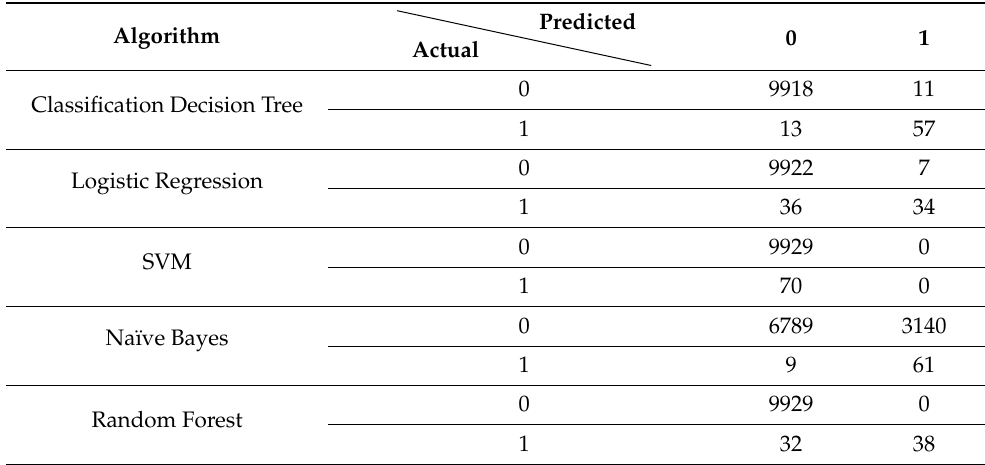
Table 3. Confusion matrix for classification